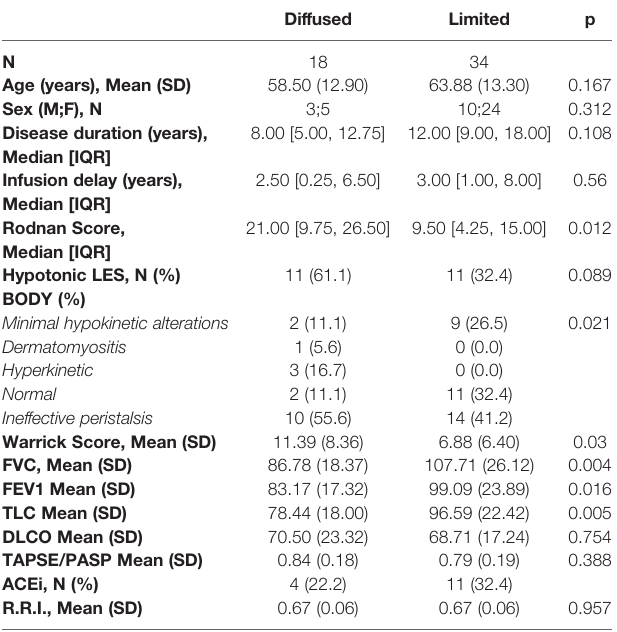
TABLE 2 | Correlation between overall characteristics, skin and organs involvement (instrumental values: mean +DS) in limited and diffuse cutaneous systemic sclerosis patients.